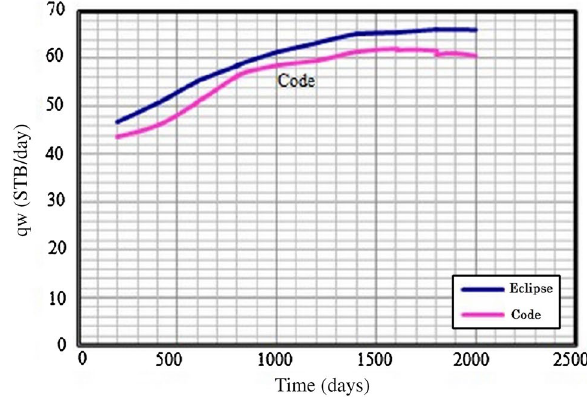
Fig. 9 Gas flow rate versus time for well No. 2 of case